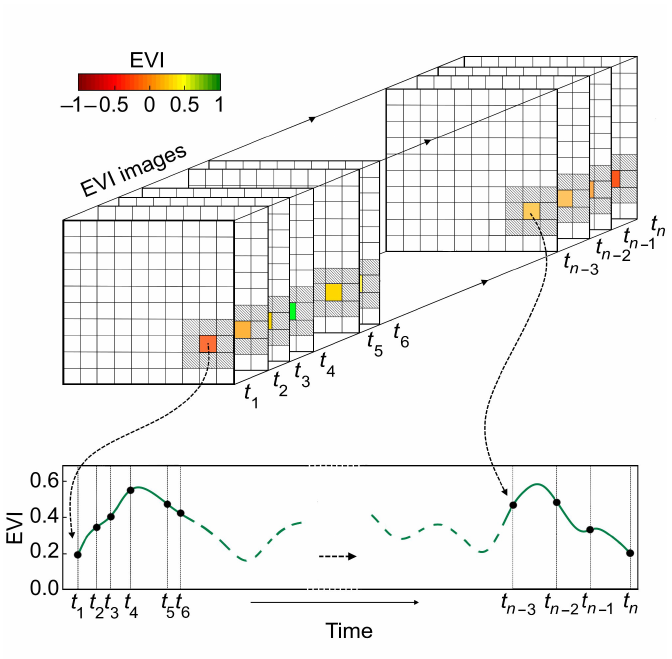
Figure 2. An illustration of obtaining per-pixel weighted EVI time series. EVI images are acquired over unequally spaced time intervals due to availability of valid satellite imagery that provide unequally spaced EVI image time series. In this illustration, each EVI image consists of 100 pixels, and so in total there are 100 unequally spaced time series whose sizes may not be the same due to several reasons, such as cloud contamination and high aerosol content. The cloud score for each spatial window of size nine is used to define an appropriate weight for the pixel located at the window center (see the shaded gray pixels around the pixel in a solid color for each